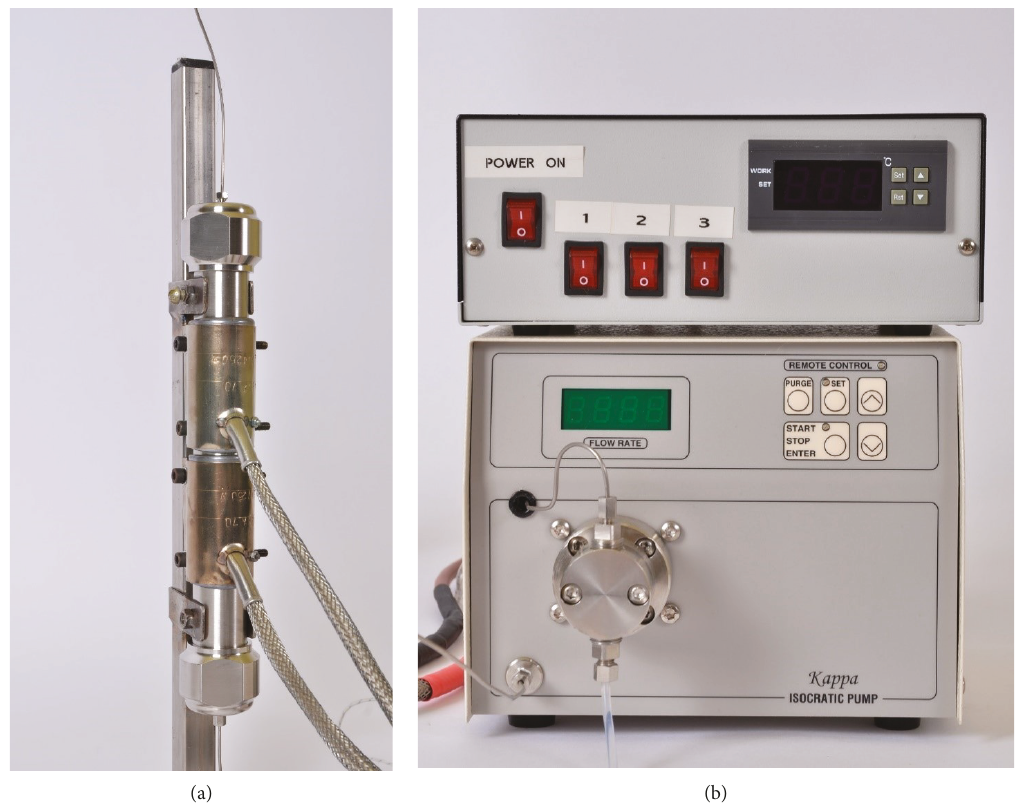
Figure 3: Flow-through reactor (a) and temperature control on top of the HPLC pump used